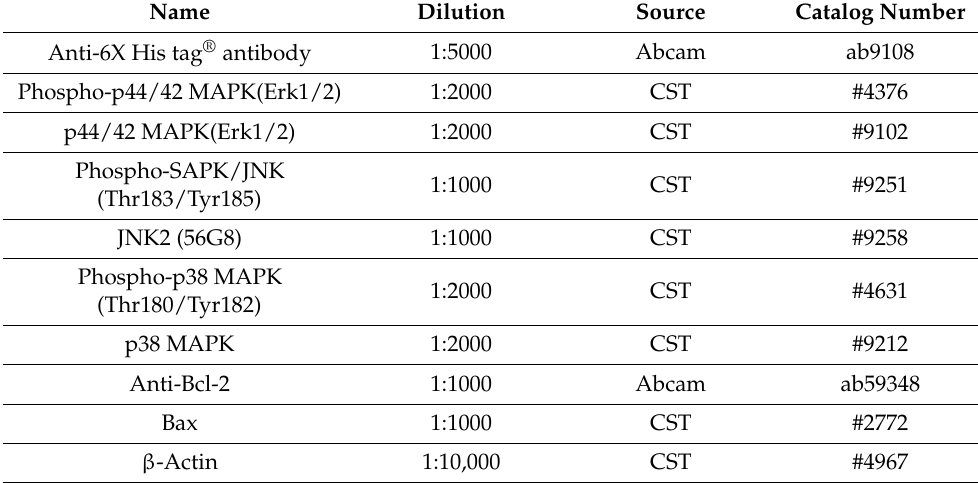
Table 1. Information on the primary antibodies used for